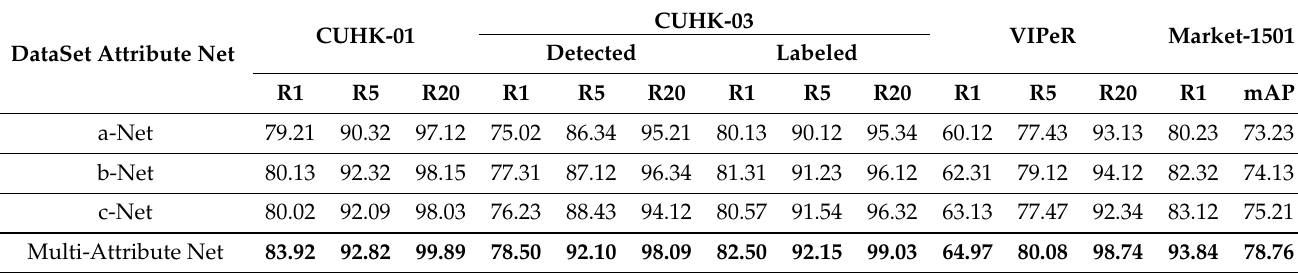
Table 6. The performance of the single sub-Net.